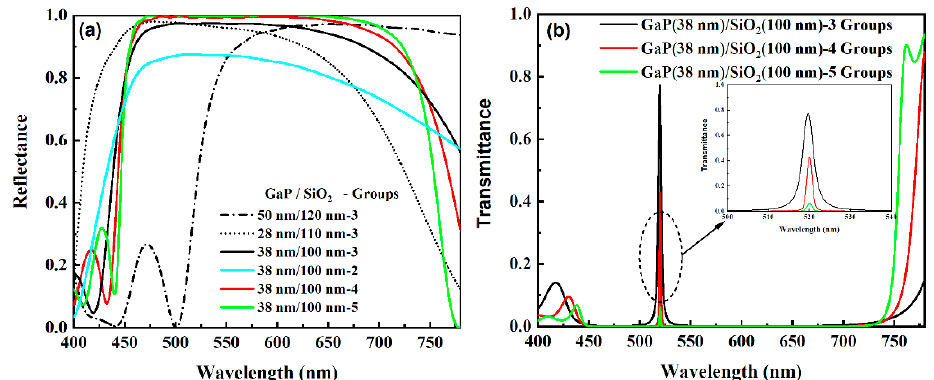
Figure 3. Reflective spectra ( a ) of the distributed Bragg reflection (DBR) reflectors with various structural parameters and transmissive spectra ( b ) of the Fabry–Pérot (FP) cavity with different numbers of GaP/SiO 2 pairs. The inset of the left chart is an enlargement of the transmissive spectra at the center wavelengths.